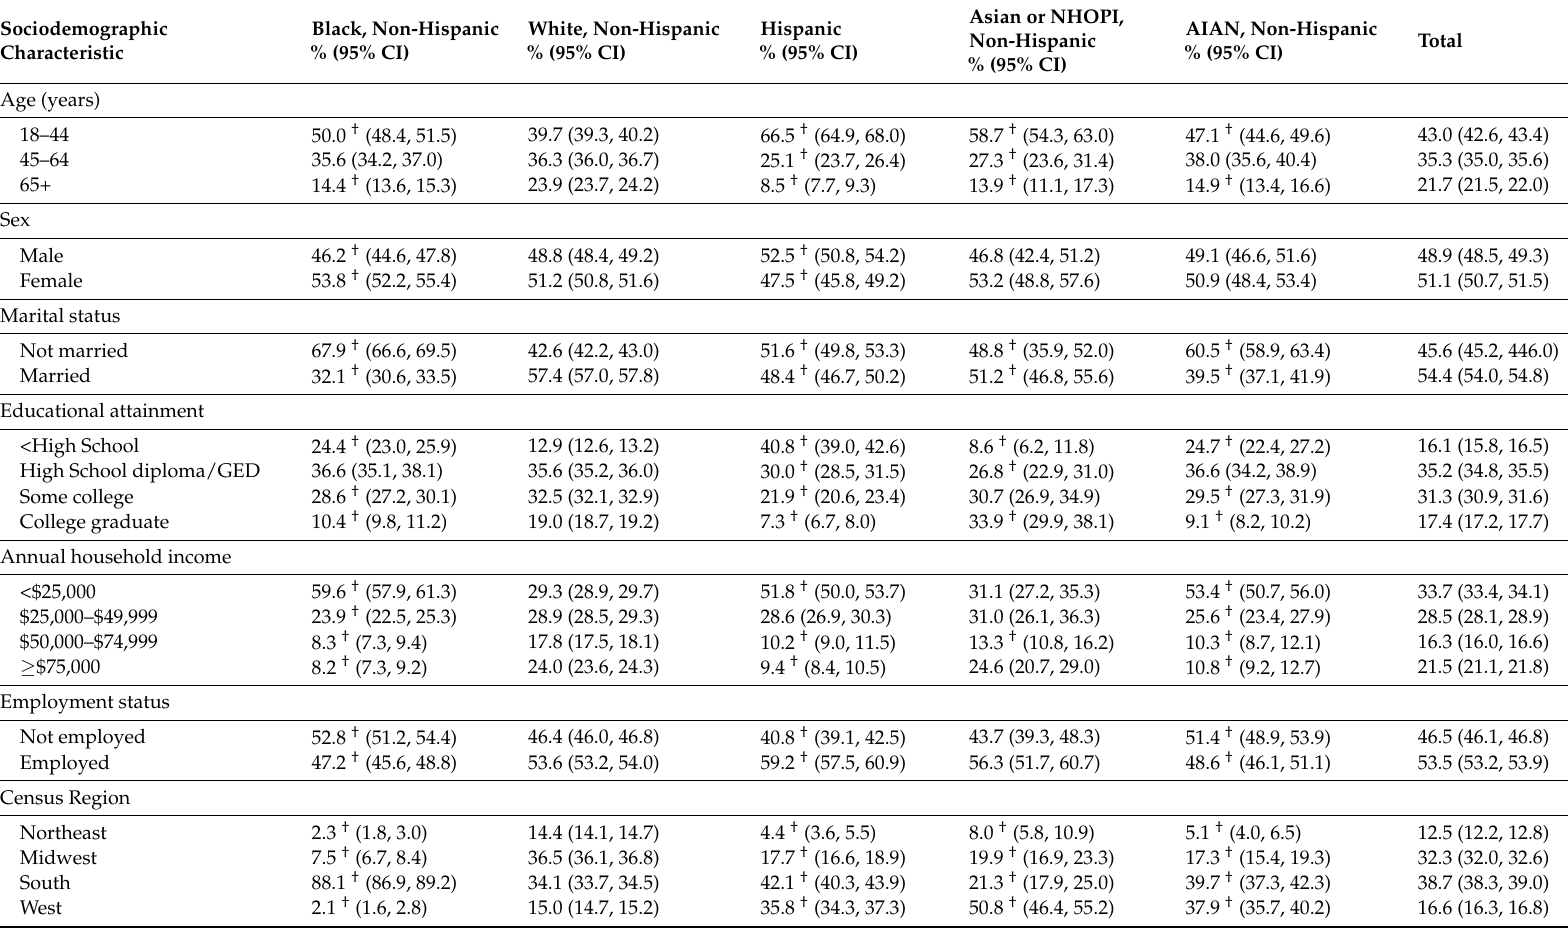
Table 2. Sociodemographic characteristics of micropolitan dwelling adults * by race and ethnicity: Behavioral Risk Factor Surveillance System, United States, 2012–2015. Sociodemographic